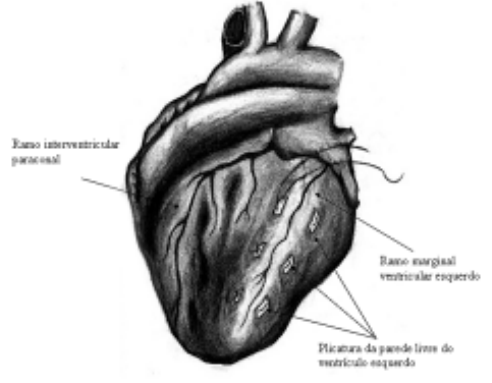
Fig. 1 – Representação esquemática da técnica de plicatura da parede livre do ventrículo esquerdo. Obs. O ramo interventricular paraconal corresponde, no cão, à artéria coronária descendente anterior